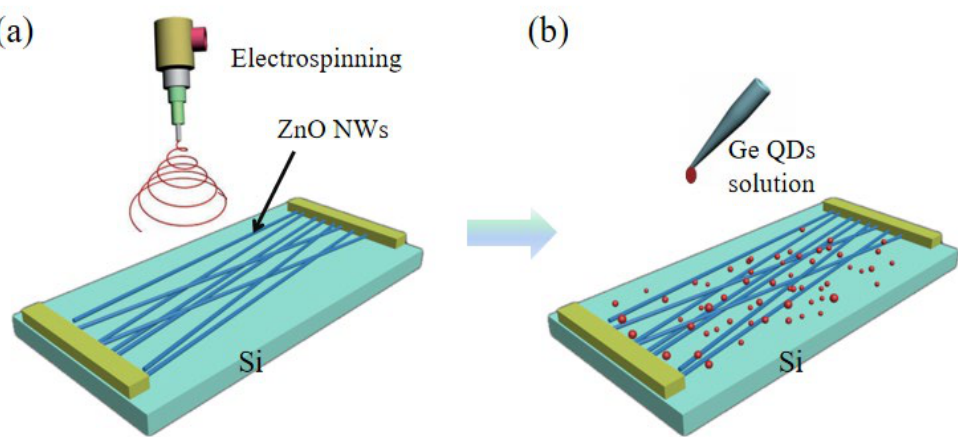
Figure 1. Schematic illustration of fabricating for Si/ZnO NWs/Ge QDs broadband PD. ( a ) A schematic view for electrospinning ZnO NWs. ( b ) A schematic spin-coating Ge QDs on ZnO NWs. Figure 2a,b show the scanning electron microscope (SEM) of ZnO at different mag- nifications. The average diameter of randomly distributed ZnO NWs is 100 nm, and the density is directly proportional to electrospinning time. There are around five ZnO NWs layers stacked longitudinally in the SEM imagine at a large magnification. In sequence, the thickness of the ZnO film is estimated as 500 nm. The element information was given in the energy dispersive X-ray (EDS) analysis spectrum shown in Figure 2c, which proves the primary composition of ZnO and Si because of the existence of Si, oxygen, and Zn